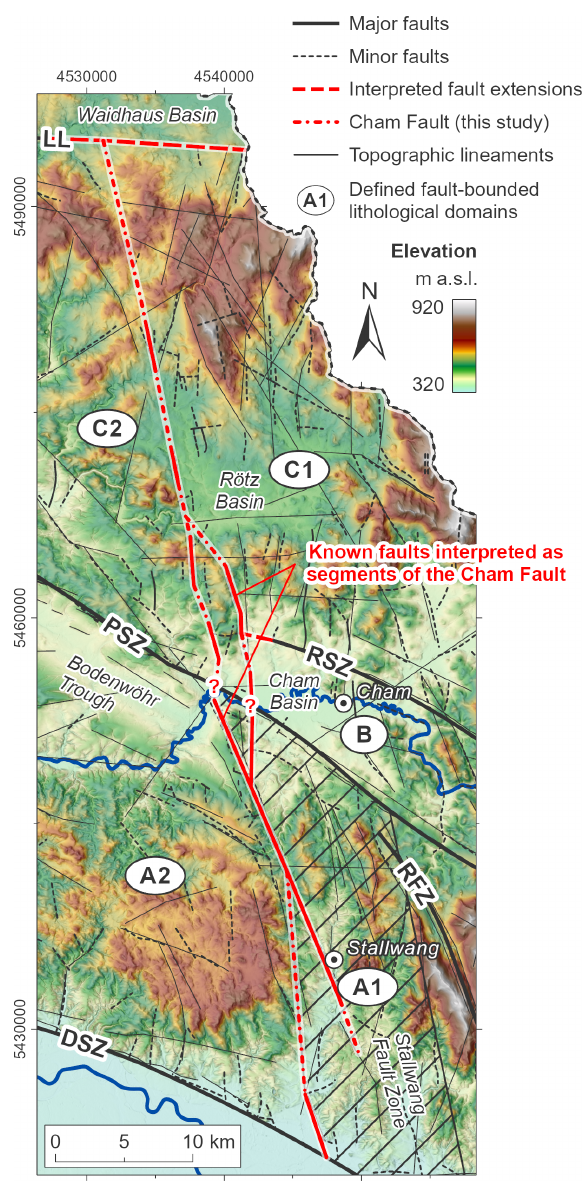
Figure 7. Detailed map of the Cham Fault as inferred from the DEM. Several faults known from the geological map are interpreted as segments of the Cham Fault (faults from Teipel et al., 2008, and Galadí-Enríquez et al., 2009b). Note the uncertainty in the location of the southernmost part of the fault, which is due to enhanced ero- sion along the Stallwang Fault Zone. Fault zones: DSZ – Danube Shear Zone; LL – Luhe Line; PSZ – Pfahl Shear Zone; RSZ – Rund- ing Shear Zone; RFZ – Rattenberg Fault